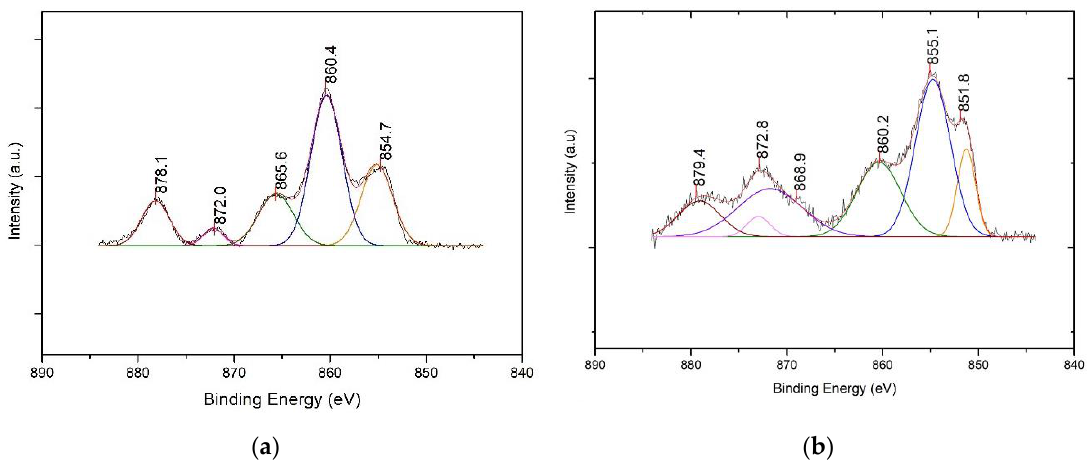
Figure 13. X-ray photoelectron spectra of ( a ) fresh and ( b ) spent 20 wt% Ni-Mg-Al catalysts.